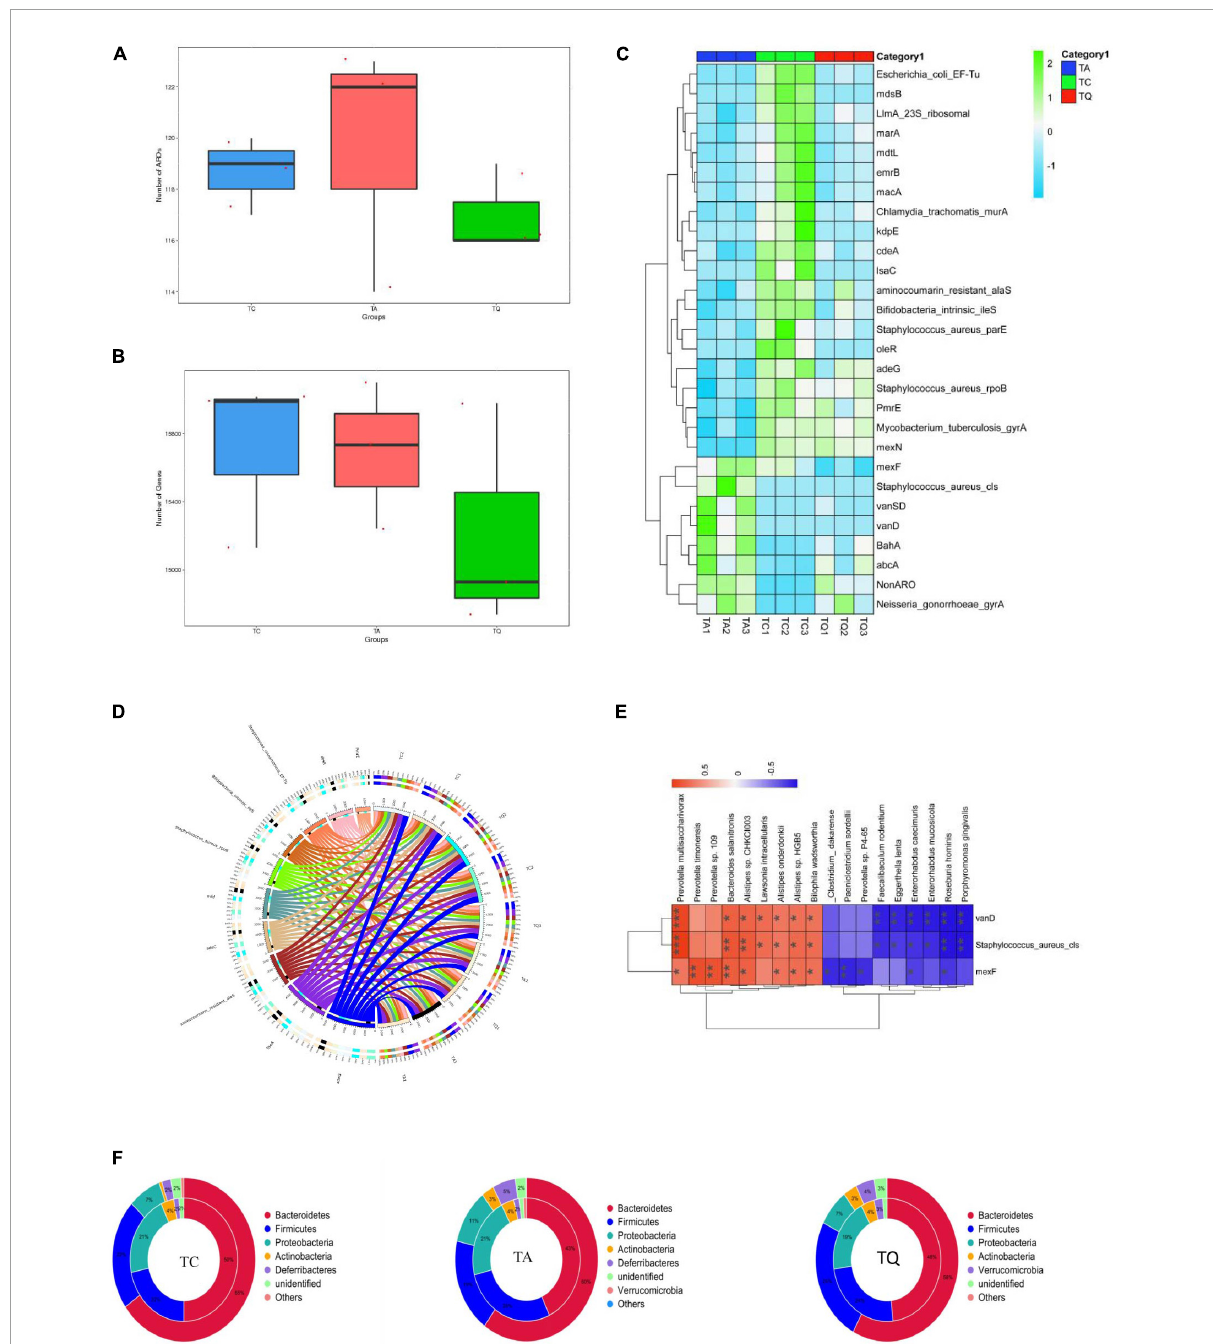
FIGURE6 Antibiotic resistance gene annotation on CARD database (A) , (B) Comparation of gene number and ARO annotation; (C) Top 10 AROs detected on samples; (D) Significantly different AROs within groups; (E) Spearmen correlation analysis of ARO and bacteria species; (F) ARO origin analysis at phylum